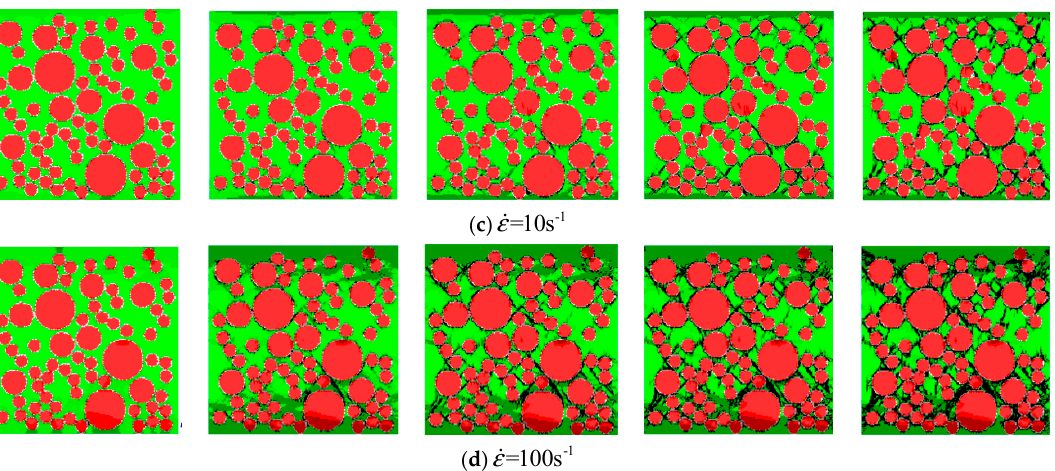
Figure 11. The damage process of concrete specimen 1 under dynamic uniaxial compressive stress; . . . . ε = 0.001 s − 1 ; ( b ) ε = 1 s − 1 ; ( c ) ε = 10 s − 1 ; ( d ) ε = 100 s − 1 . ( a )